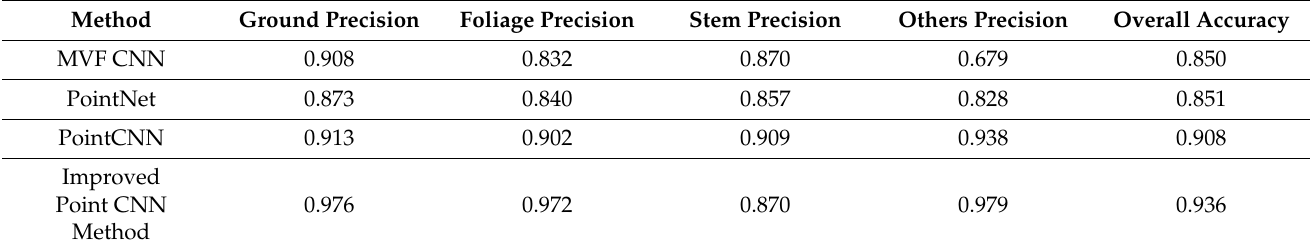
Table 4. Comparison of the Precision of each